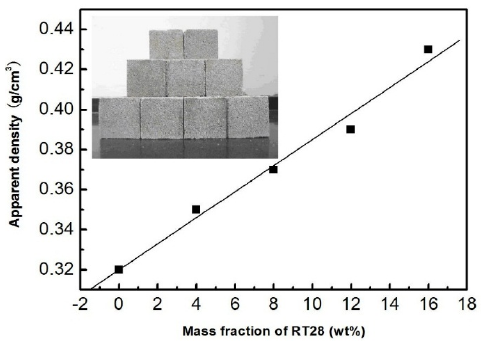
Figure 4. Relation between the apparent density of the cubes and the mass fraction of RT28 (the insert is the photograph of the cubes).